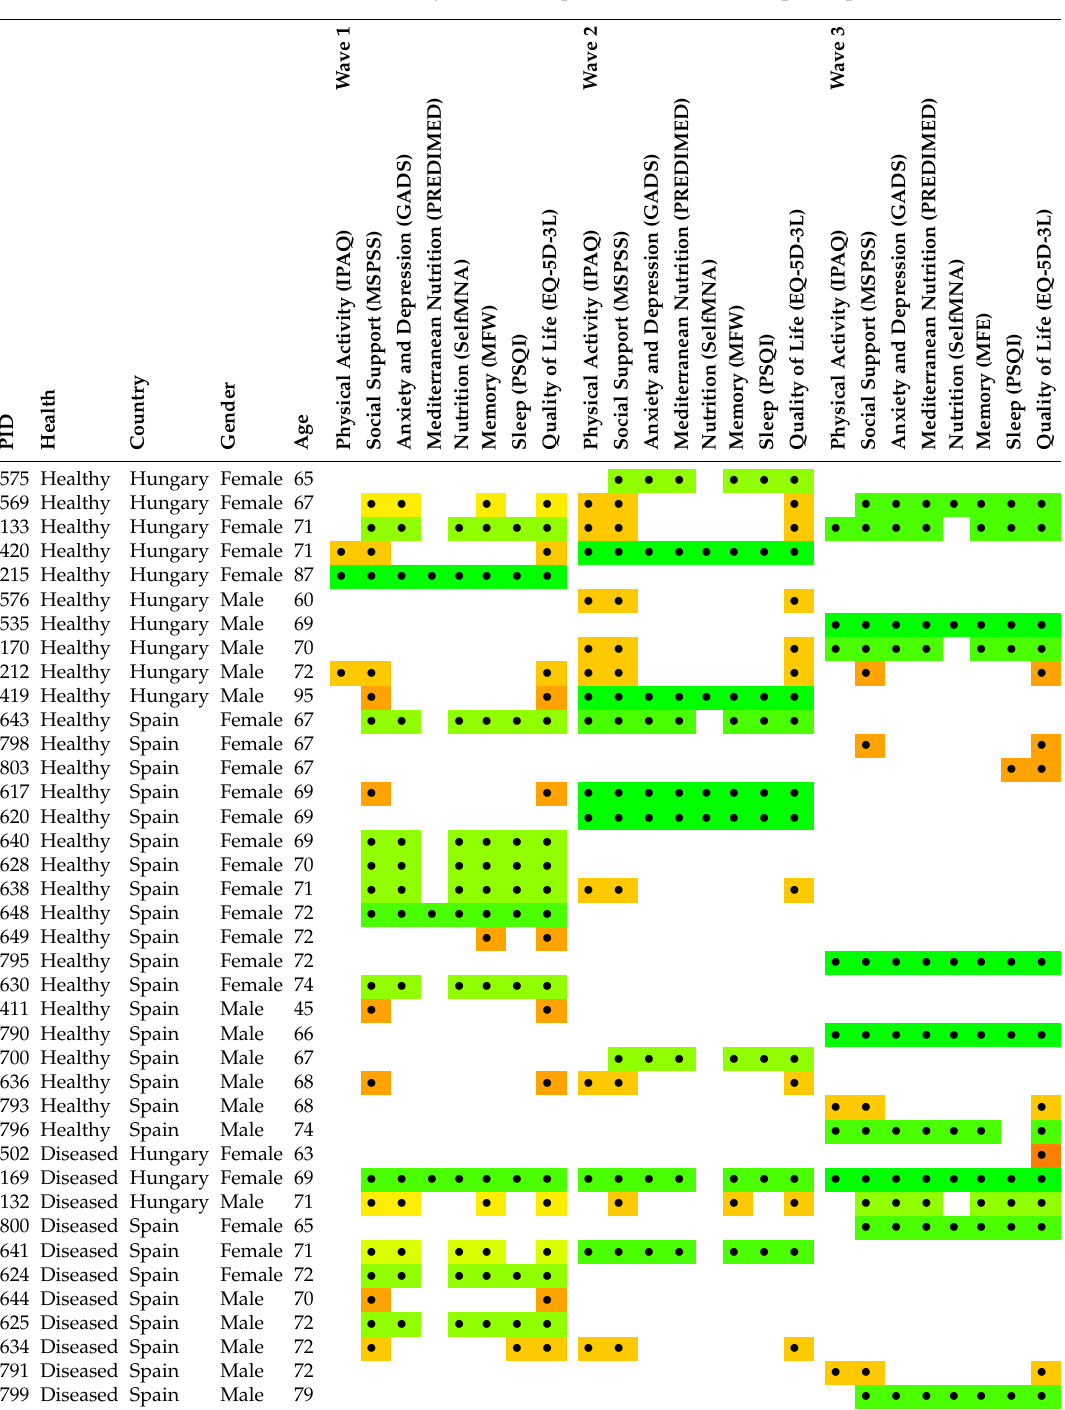
Table 5. PRO count answers by wave and questionnaire ( N = 39